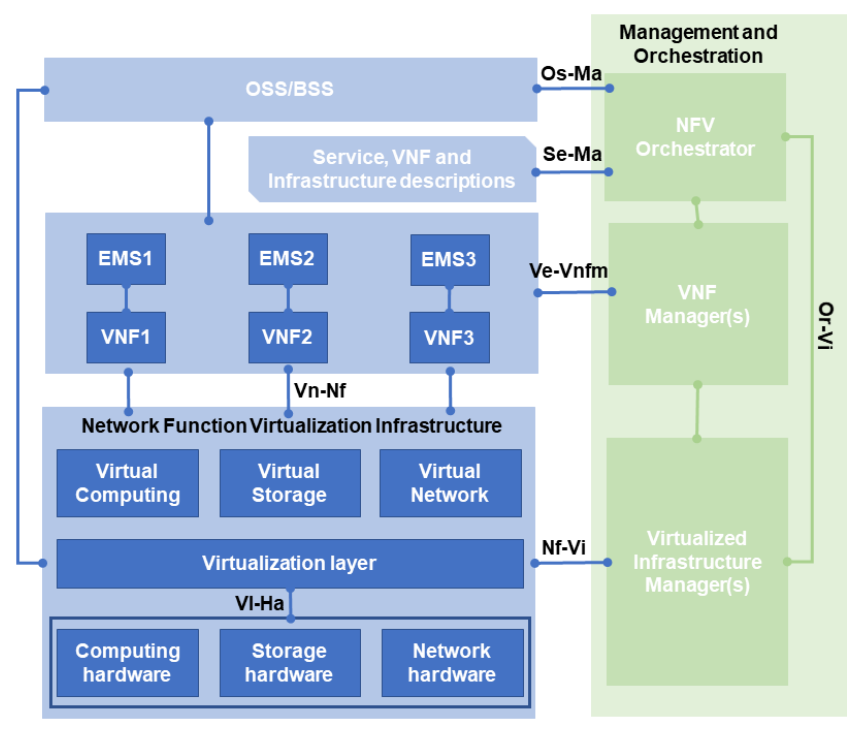
Figure 1. ETSI-NFV architecture